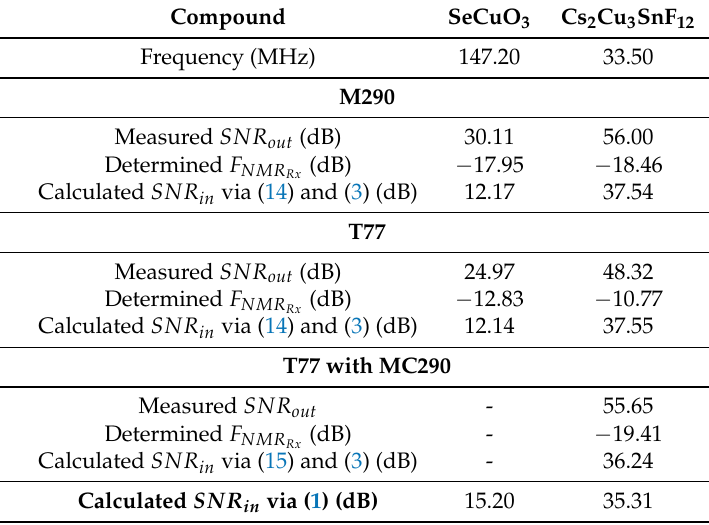
Table 3. Results of experimental verification of the derived expression for NMR spectroscopy receiving